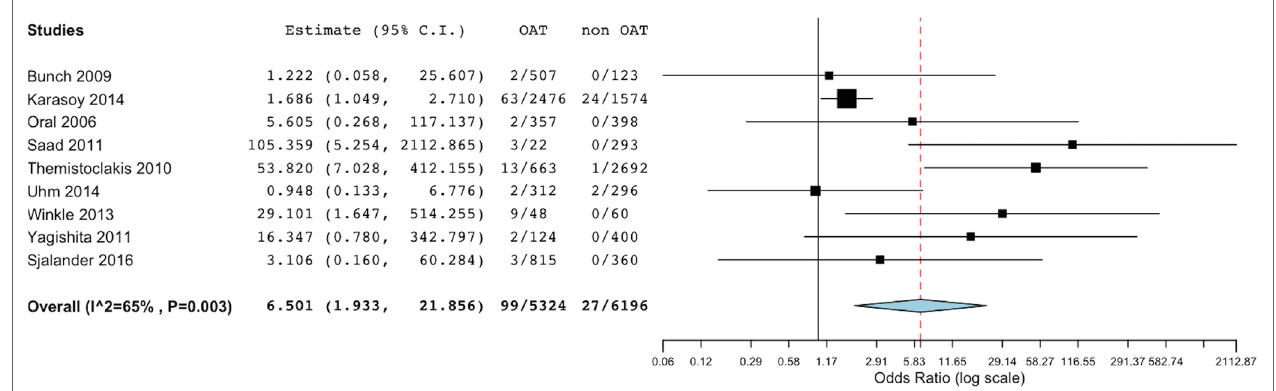
FiGUre 4 | Meta-analysis of difference in total bleeding events. Forest plot and summary effect of the difference in the incidence of total